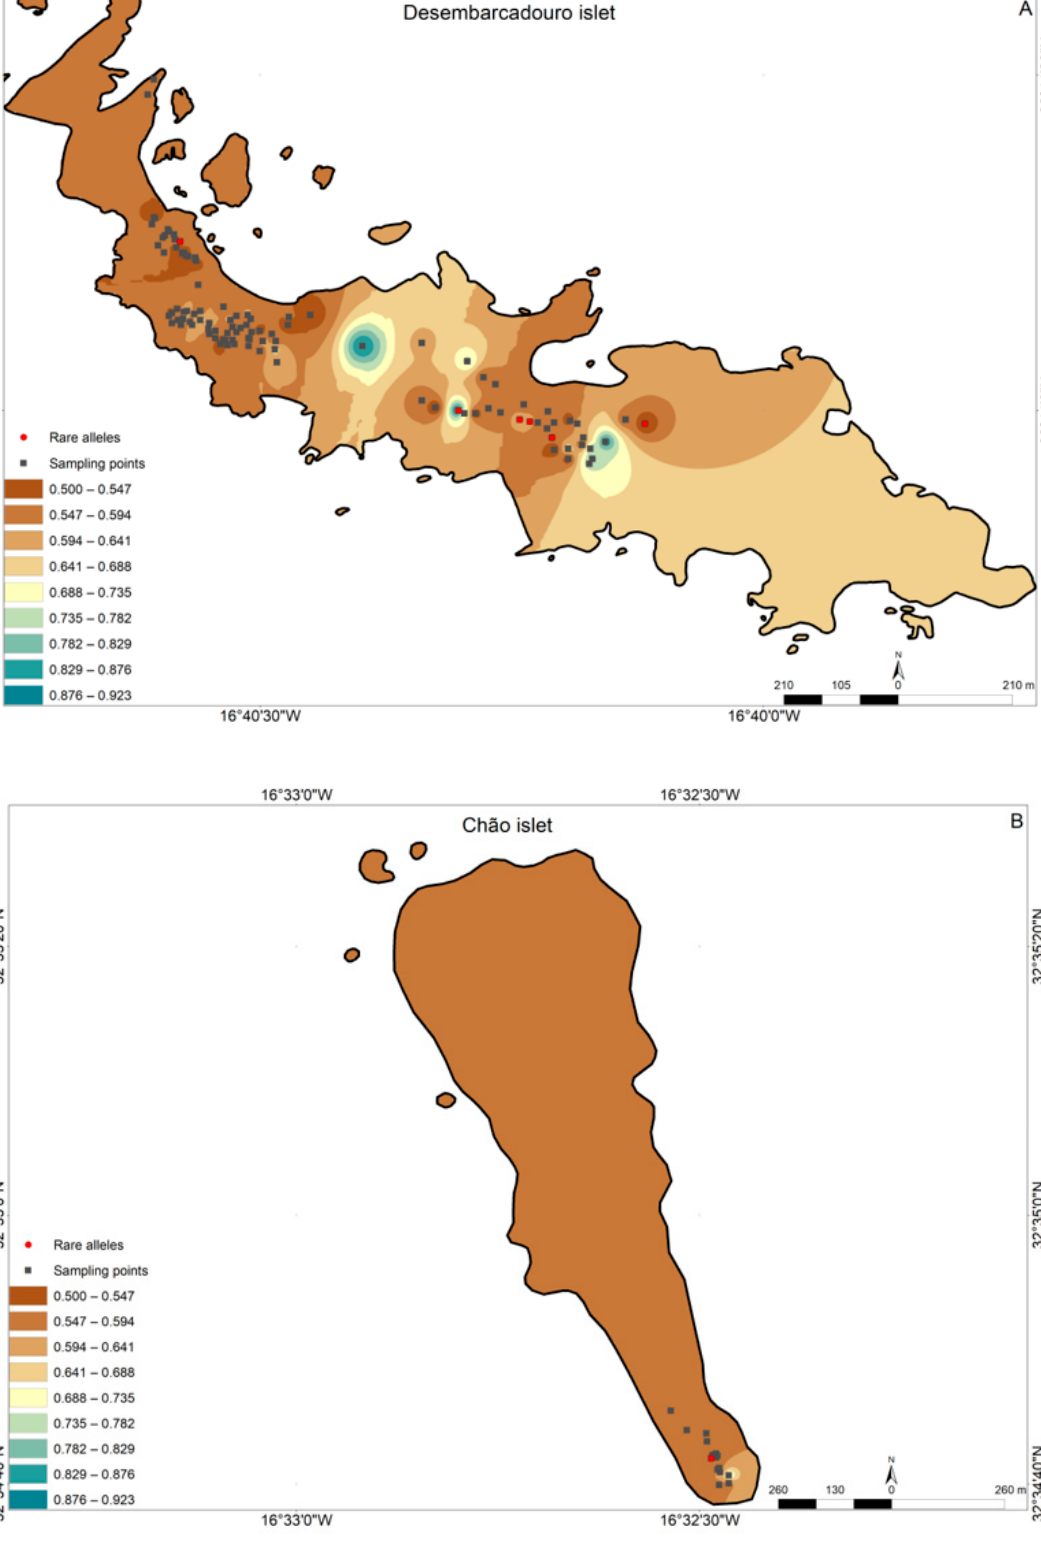
Figure 3. Heatmaps of Desembarcadouro islet ( A ) and Chão islet ( B ). Bluish regions in the heatmaps indicate a higher allele frequency and brownish regions indicate lower ones. Red dots indicate individuals that scored for rare alleles.